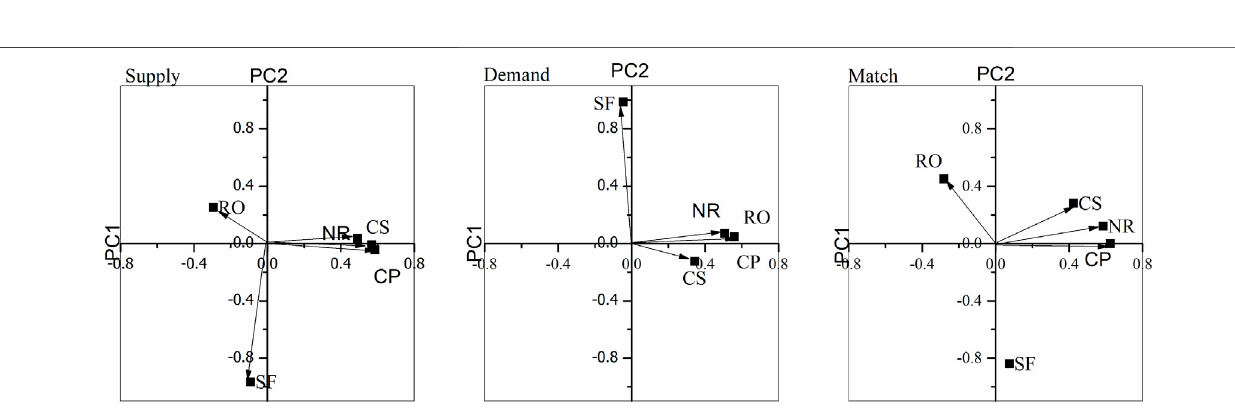
Frontiers in Environmental Science |